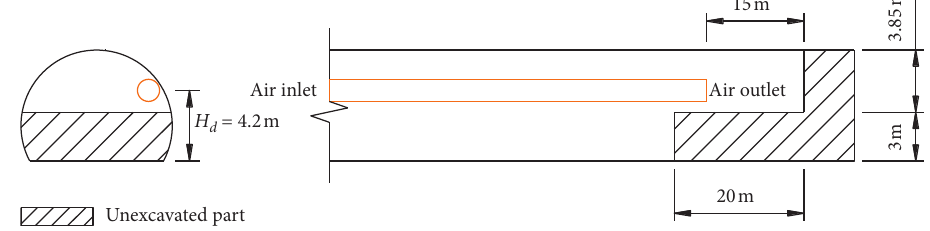
Figure 4: Ventilation diagram of the benching tunneling method.